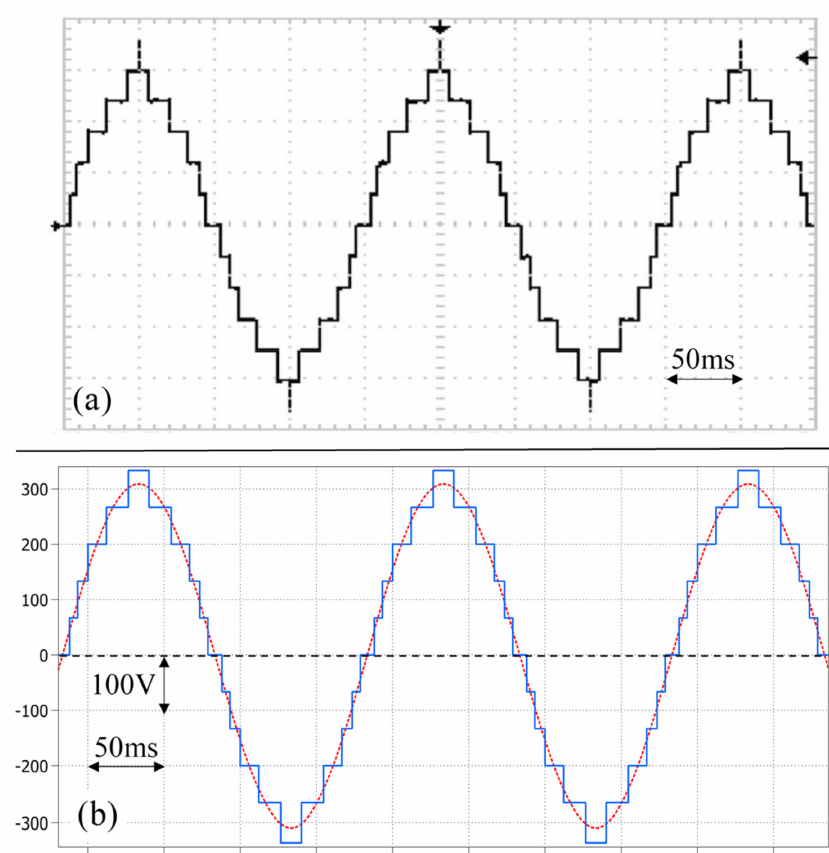
Figure 11. Line voltage SCM waveforms for m a = 0.772. ( a ) Experimental results in [9], ( b ) corre- sponding processor-in-the-loop waveform with first harmonic indicated (dashed